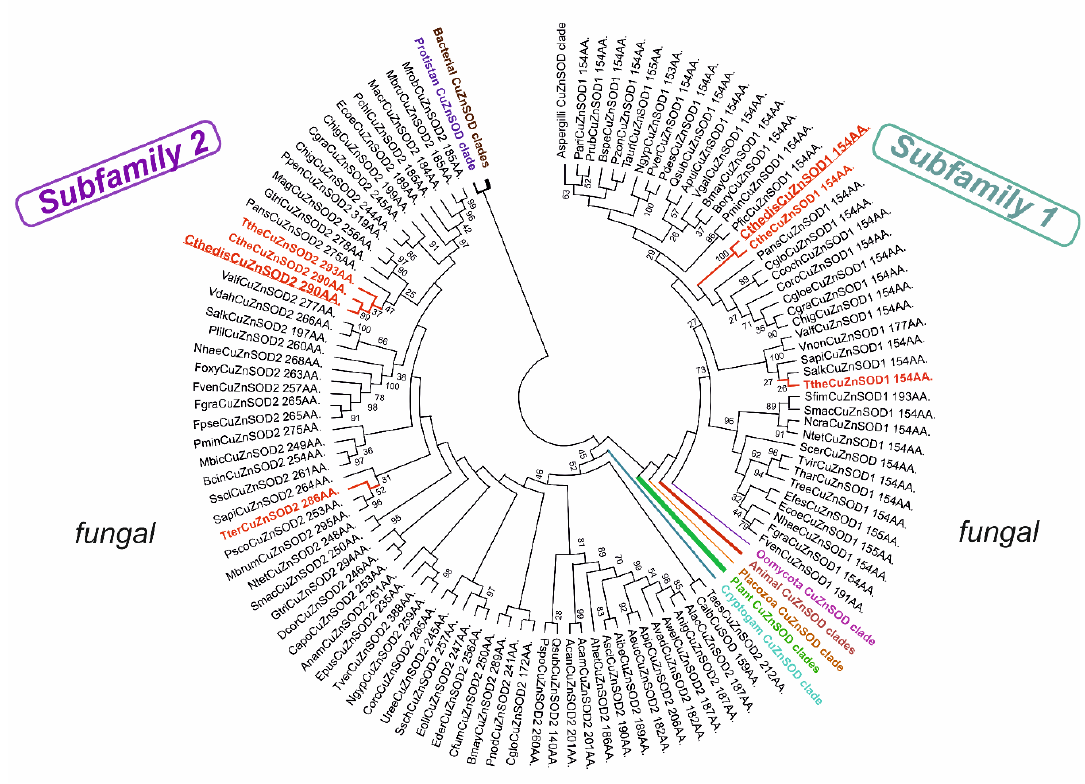
Figure 2. Global phylogenetic tree of the CuZnSOD family. This reconstruction was obtained with the maximum likelihood method of MEGA-X package [15] by using Whelan and Goldman model of substitutions. It contained 330 full length sequences of CuZnSODs. Partial deletion with 14% sites coverage and 100 bootstrap replications were used in this reconstruction. Only bootstrap values above 25 are shown. There were in total 207 amino acid positions used in the final dataset. Sequences from thermophiles are labeled in red. Abbreviations of used sequences are explained in Table S2.